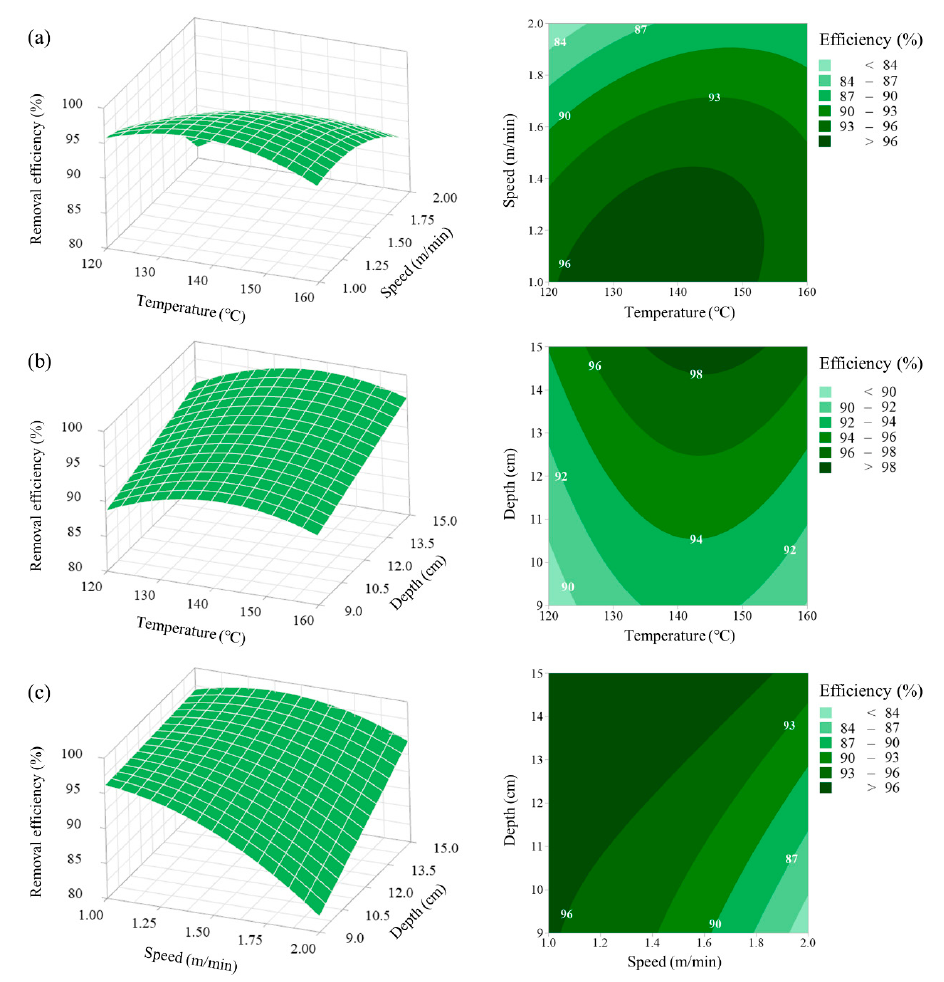
Figure 3. Response surface plots presenting the interaction effects of three variables on the total bacteria removal efficiency: ( a ) surface plot showing the effect of the steam temperature and running speed on removal efficiency, ( b ) surface plot showing the effect of the steam temperature and spray depth on removal efficiency, and ( c ) surface plot showing the effect of the running speed and spray depth on removal efficiency.